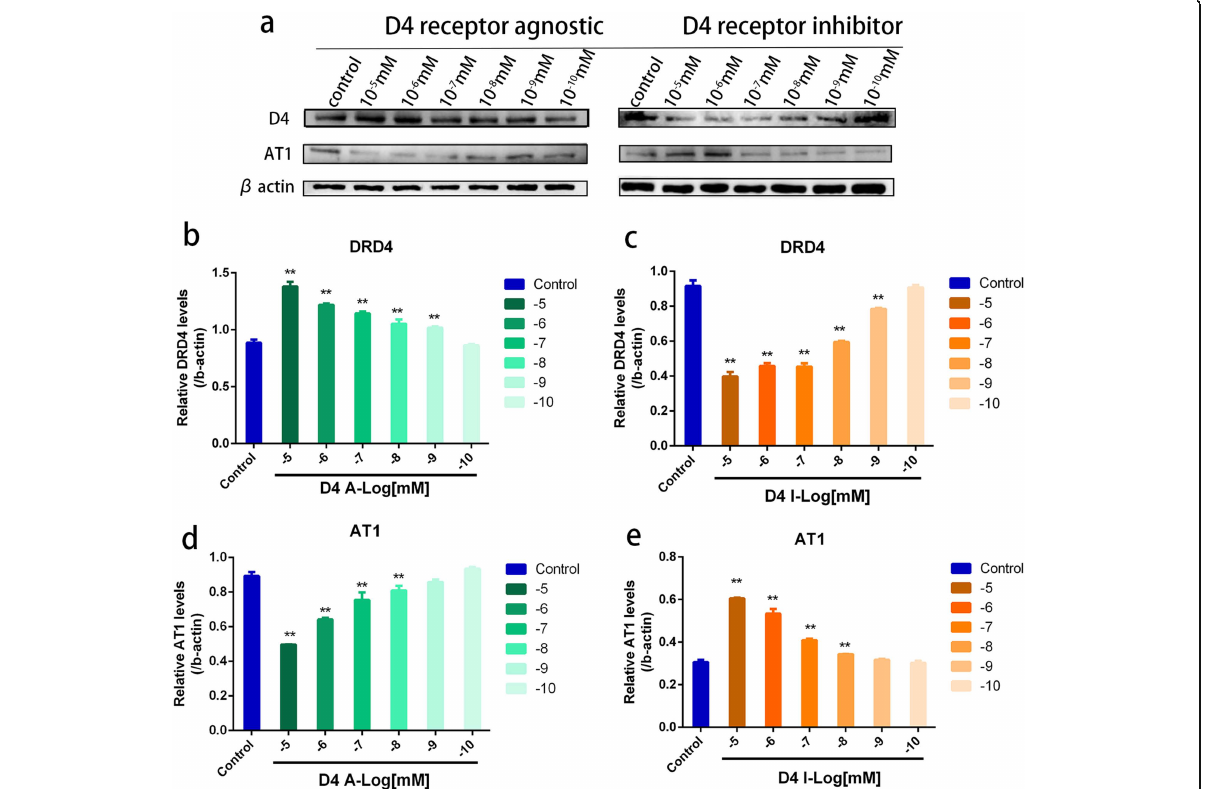
Fig. 7 Effect of dopamine receptor D4 (DRD4) on angiotensin II type 1 receptor (AT1) protein expression in primary vascular smooth muscle cells (VSMCs) of broilers. VMSCs were incubated with different doses of D4A or D4I for 24 h. a , b , c Dose-dependent effect of D4A (HY-101384A) or D4I (HY-B0965) ( n = 6, ** P < 0.01 vs. control). a , d , e The dose-dependent effect of D4A or D4I ( n = 6, ** P < 0.01 vs.